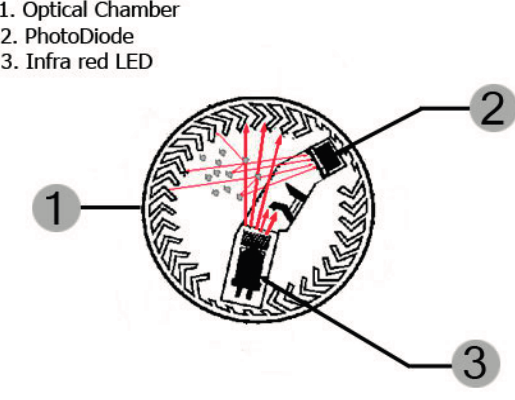
Figure 2. Chamber of the smoke